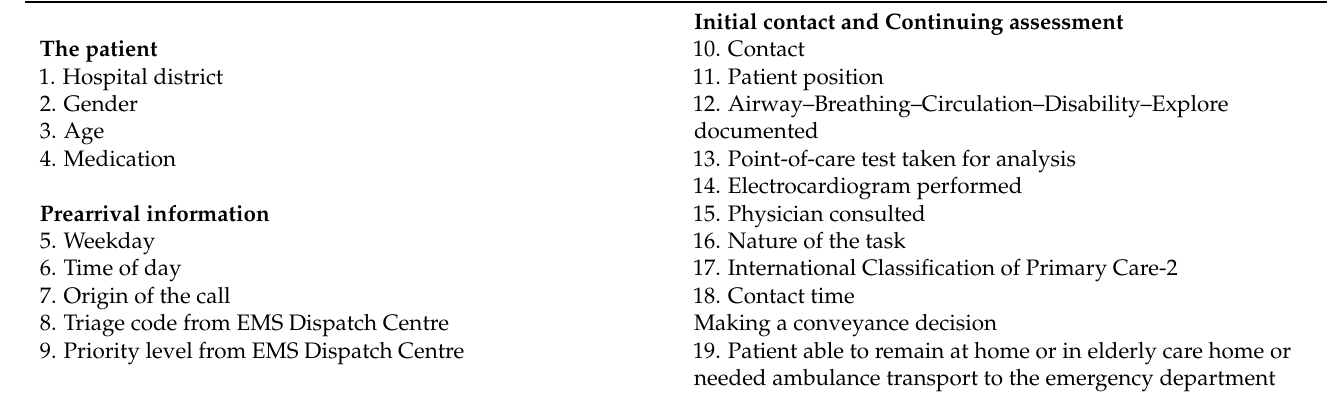
Table 1. The variables involved in the CNPs’ decision-making process.